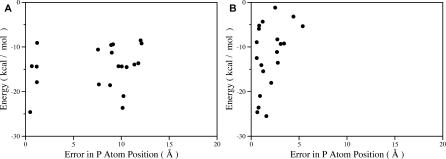
CDK2 Case StudyThe 20 lowest-energy loops predicted for (A) reconstruction of residues 152–163 in phosphorylated, cyclin-bound CDK2; and (B) prediction of the structure of residues 152–163 upon in silico phosphorylation of Thr160 in the unphosphorylated, cyclin-bound CDK2. In each case, the loop and surrounding side chains are optimized simultaneously as described in Materials and Methods.